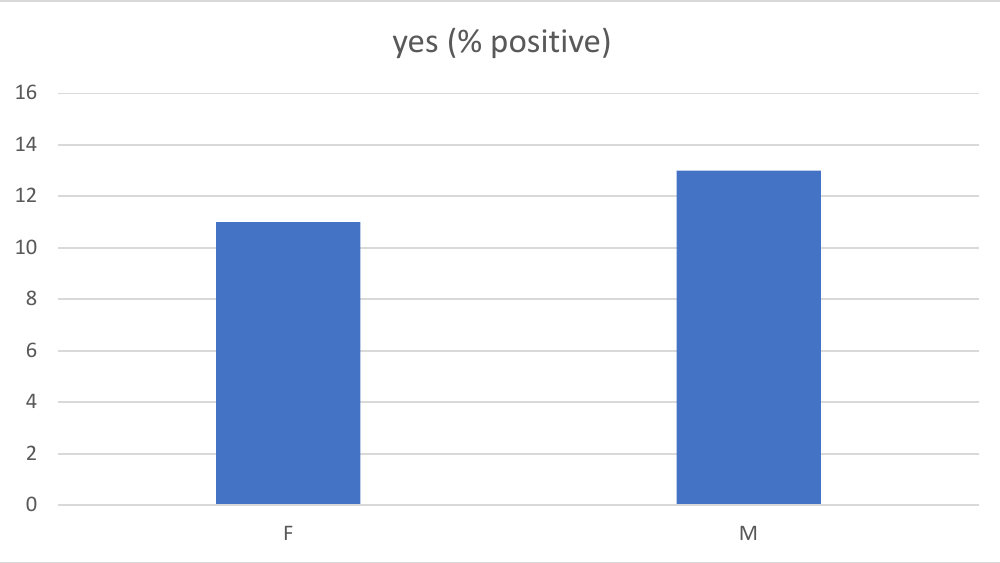
Figure 3. Dependence on sex positivity ( p = 0.574).